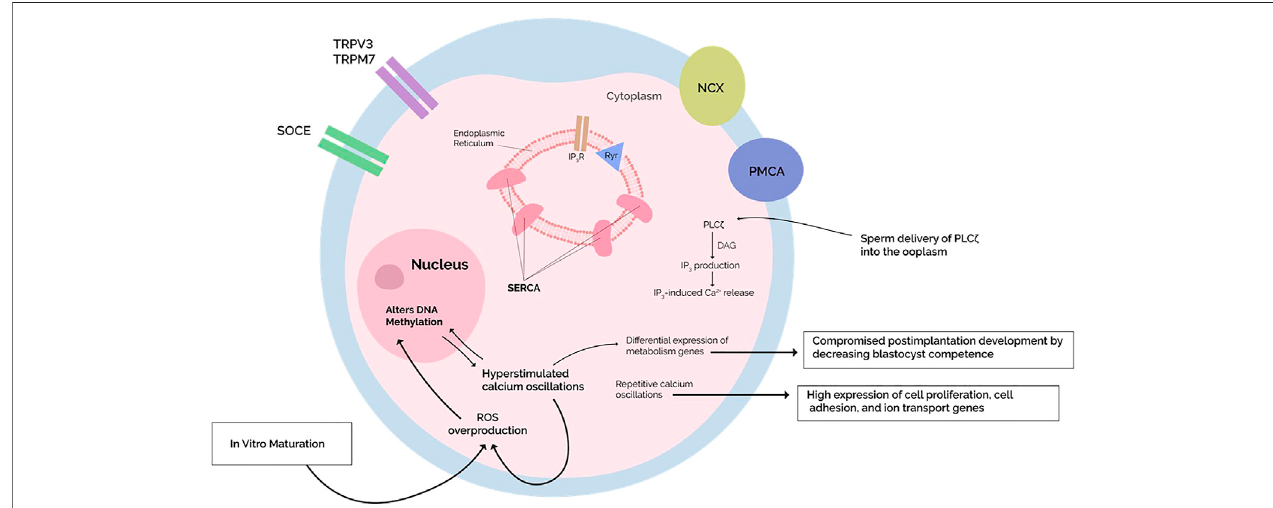
FIGURE 2 | Repetitive calcium oscillations approximating in vivo fertilization feature a differential gene expression with high expression of cell cycle, cell adhesion, and ion transport genes. On the other hand, hyperstimulation of calcium oscillations compromises postimplantation development by lowering blastocyst competence with high expression of metabolism-related genes. Simultaneously, the Hyperstimulated calcium transients increase the production of reactive oxygen species (ROS), which are known to induce changes in DNA methylation through oxidative stress. The mechanisms underlying the observed differential expression are unknown, but whencoupled withmountingevidence ofcalcium-dependentROSgenerationalteringtheoocyte DNA methylome, perhaps these epigenetic alterations accountfor the differential expression. Studies investigating a potential causal relationship are warranted. In vitro maturation (IVM) protocols generate increased oxidative stress on the oocyte, altering DNA methylation programs during oocyte maturation — differential expression is indeed reported after IVM, but whether it also disrupts calcium homeostasis and what effects this has on postfertilization calcium oscillations remains investigational.